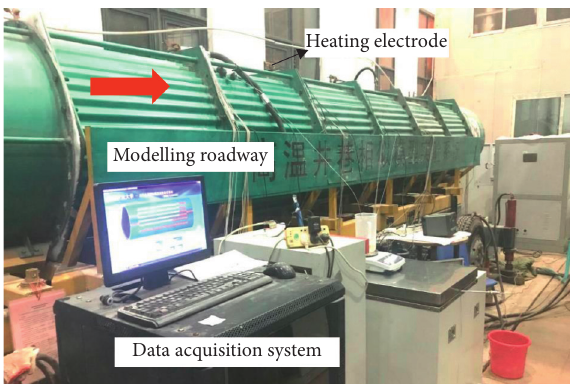
Figure 1: The experimental